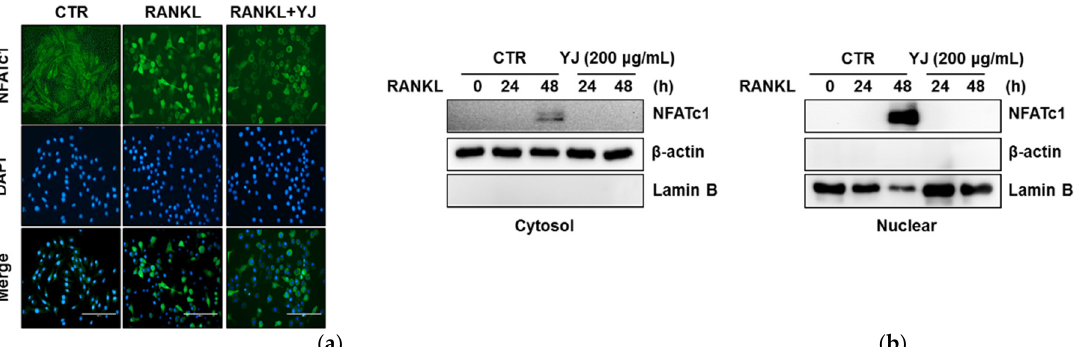
Figure 6. YJ suppresses RANKL-mediated nuclear translocation of NFATc1. The BMMs were treated with M-CSF and RANKL in the presence or absence of YJ (200 µ g/mL). ( a ) Cells were fixed with 4% paraformalin, permeabilized with 0.1% Triton X-100, and stained with NFATc1 antibody (green) and DAPI (blue). ( b ) Nuclear and cytoplasmic fractions were analyzed using Western blot analysis. Lamin B and β -actin served as the loading controls for nuclear and cytoplasmic proteins, respectively. The data are presented as the mean ± SD of three independent